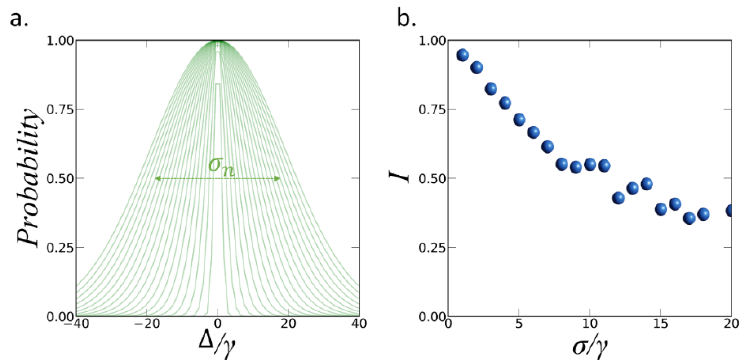
Figure 4. ( a ) Probability distributions with standard deviation σ n for n = 1 . . . 20 for the normalized detuning values ∆ / γ . At each iteration we set a random ∆ value for each QD according to the corresponding distribution. ( b ) Average value of the indistinguishability obtained for each of the 20 probability distributions.